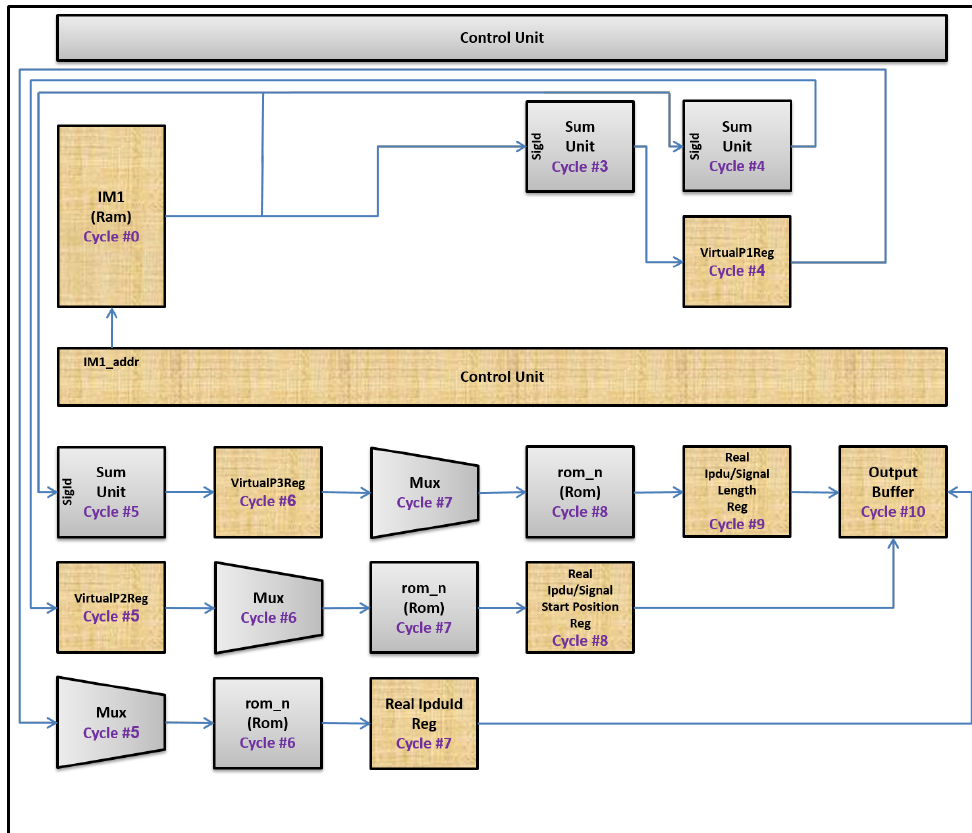
Figure 2. The additions to AUTOSAR COM ASIP to support the long signal